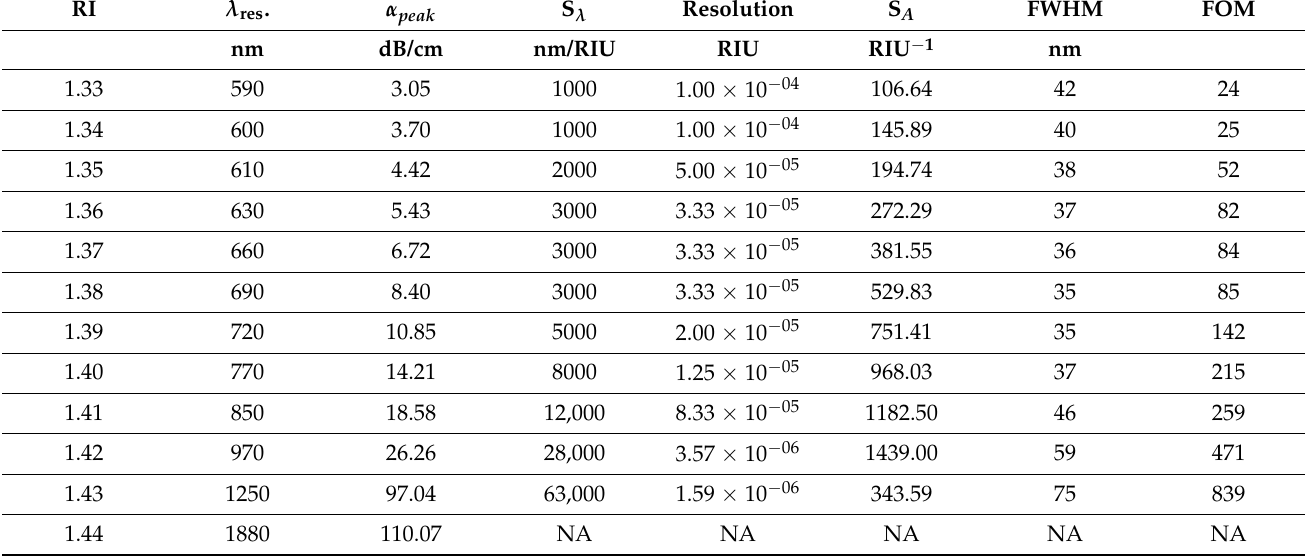
Figure 4. Sensor characteristics for analyte RI ranging from 1.33 to 1.44: ( a )confinement loss as a function of wavelength, ( b )different analytes’ amplitude sensitivity as a function of wavelength, ( c )resonant wavelength and their polynomial fitting as a function of analyte RI, and ( d ) FWHM and FOM as a function of analyte RI. Table 1. Performance of sensor for analyte RI from 1.33 to 1.44. RI λ res